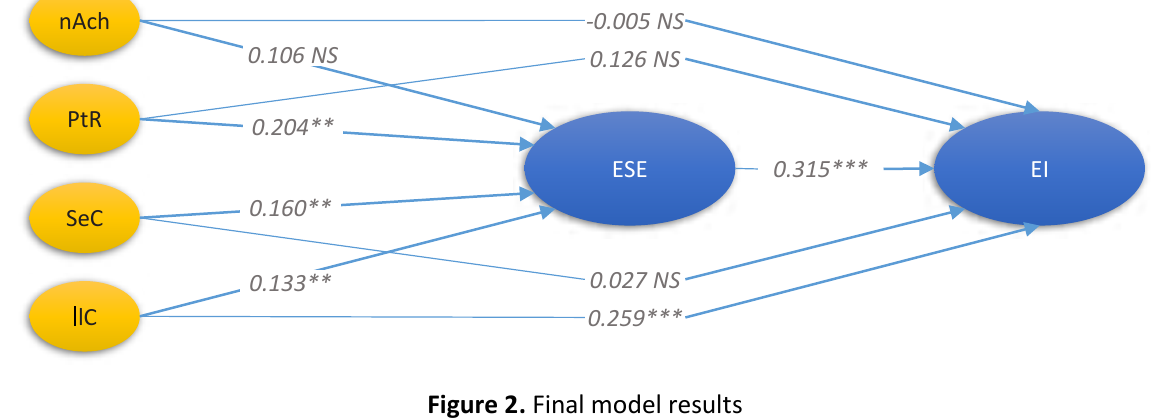
Figure 2. Final model